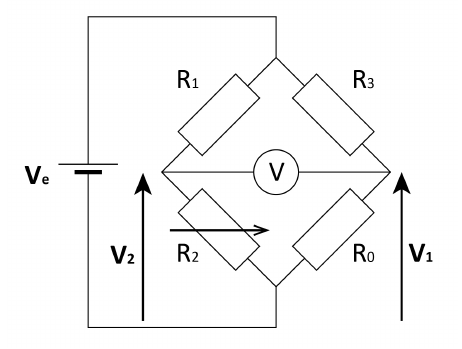
Figure 2: Schematic representation of the Wheatstone bridge: R 1 and R 3 are fixed resistances, R 2 is a tunable resistance, and R 0 is the resistance of interest.